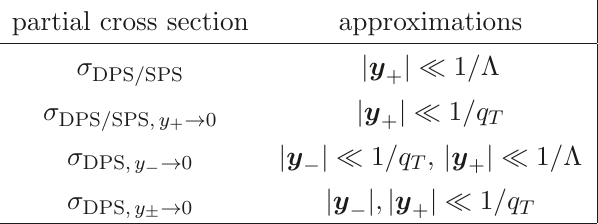
for different terms in the overall cross section (5.30) if q T ± and the associated subtraction terms. In all cases one has SPS/DPS